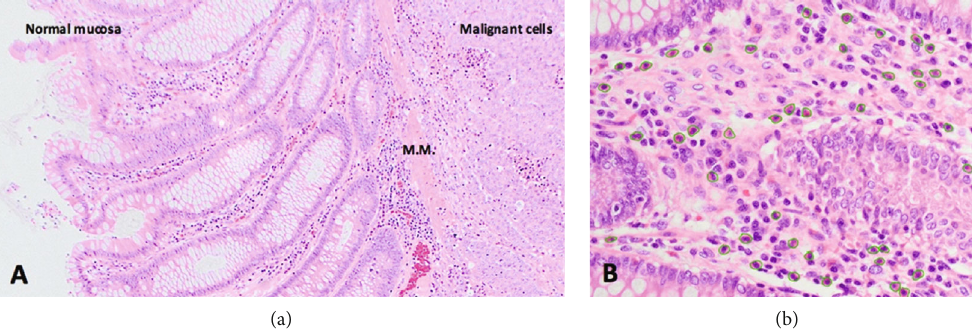
Figure 4: (a) Normal mucosa separated by an intact muscularis mucosa (M.M.) from malignant cells in the submucosa. (b) High power view of the mucosa overlying the tumour showing neutrophils outlined in fl uorescent green; numbering > 40 per h.p.f.